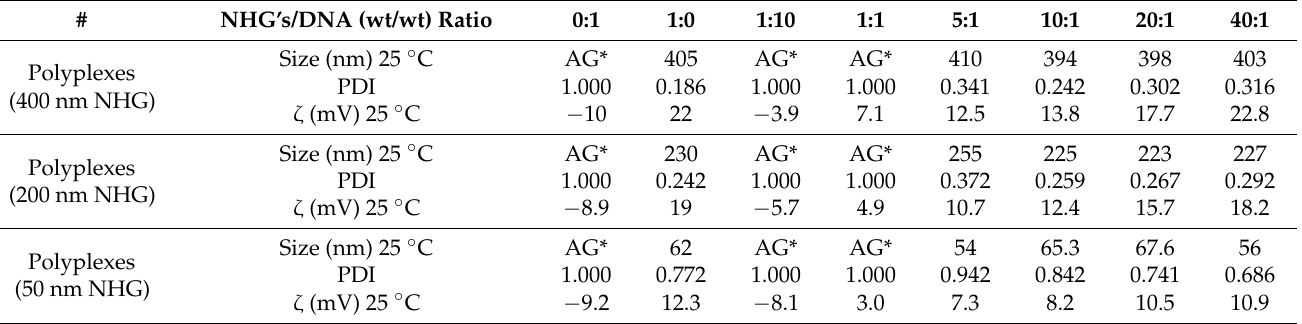
Table 3. Size and zeta potential of polyplexes (400, 200, and 50 nm).